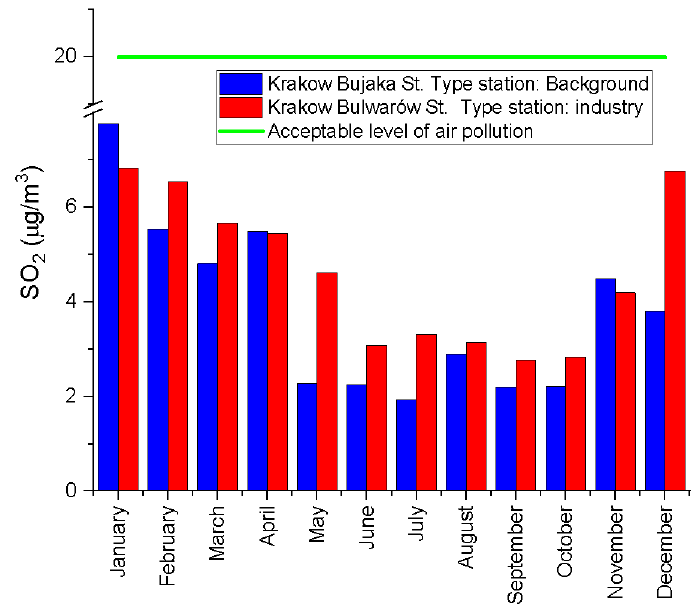
Figure 14. Average SO 2 concentration in individual months of 2020.